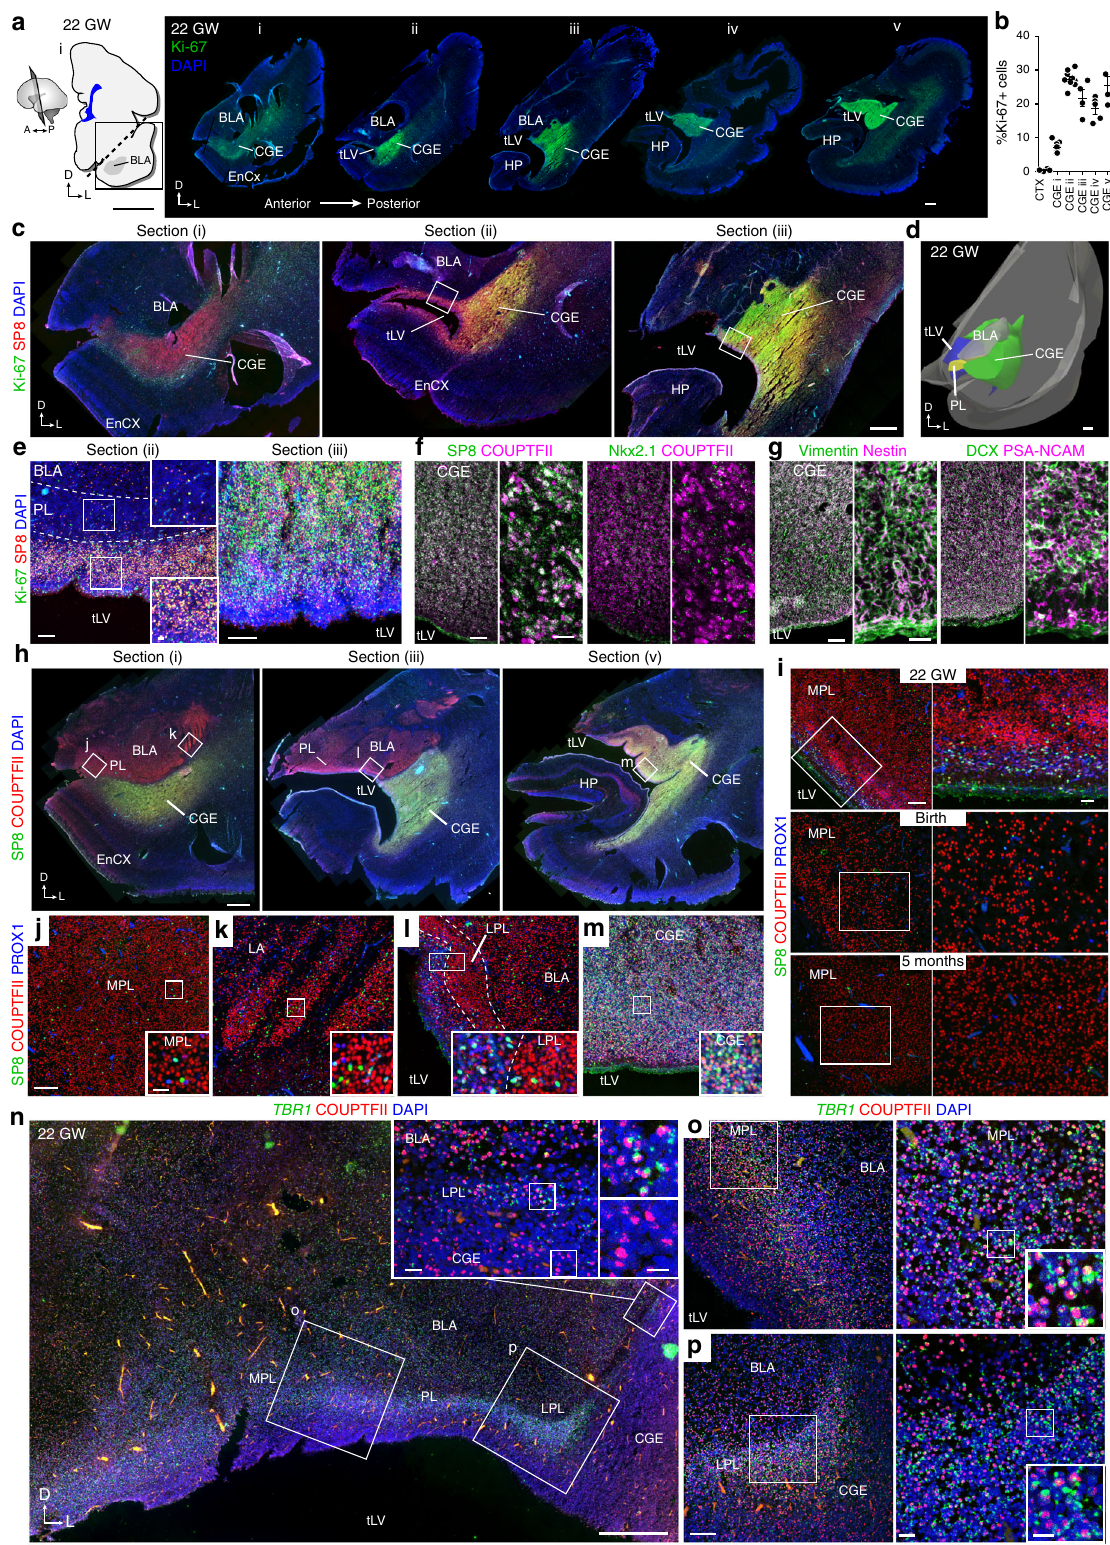
secretagogin (SCGN), expressed in CGE migratory inhibitory interneurons 39 . As expected, the CGE was densely populated with SCGN + neurons, but there were few SGCN + cells in the PL (Supplementary Fig. 1). Because these cells were negative for a marker of inhibitory neurons and distinct from the CGE,